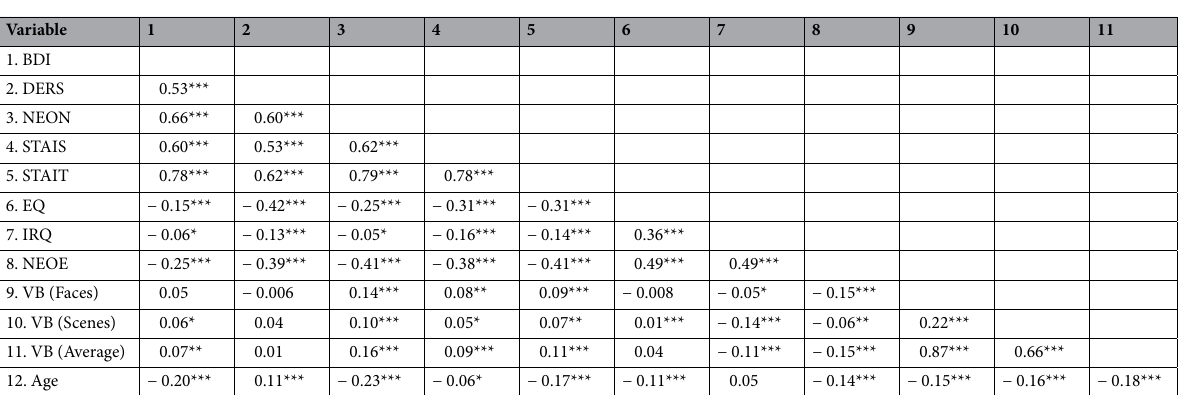
Table 1. Correlations among dependent variables. ***p < 0.001 (two-tailed), **p < 0.01 (two-tailed), *p < 0.05 (two-tailed). BDI Beck Depression Inventory, DERS Difficulties in Emotion Regulation Scale,